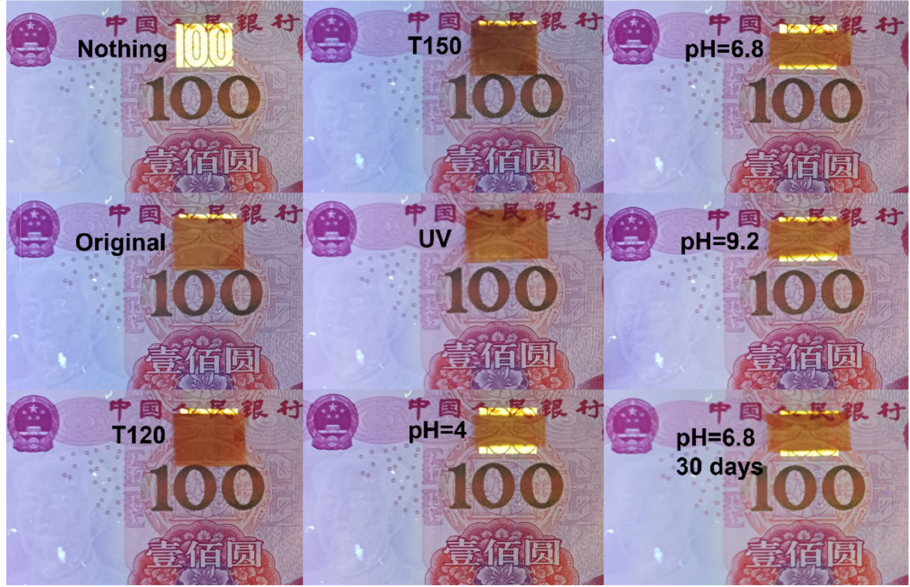
Figure 8. Paper money was shielded by M(Fe)CCF1 treated under different conditions, then exposed to UV light.